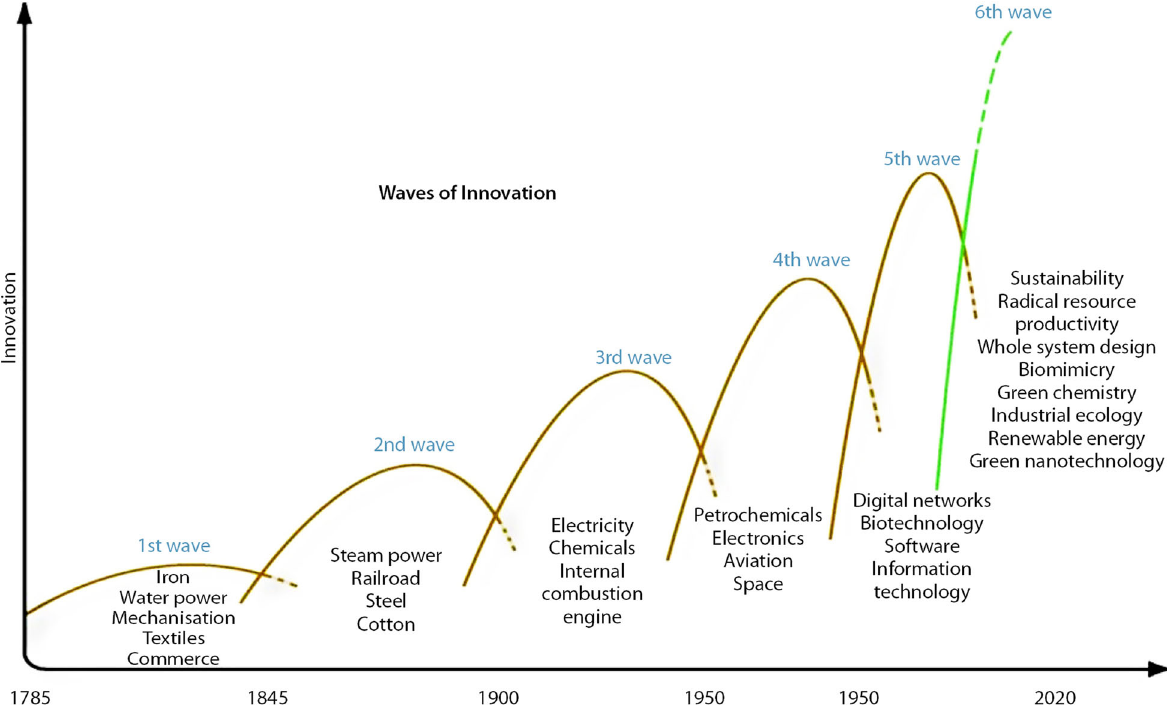
Fig. 1 Waves of innovations along the economic development. (Source: Hargroves and Smith 2005, 17)